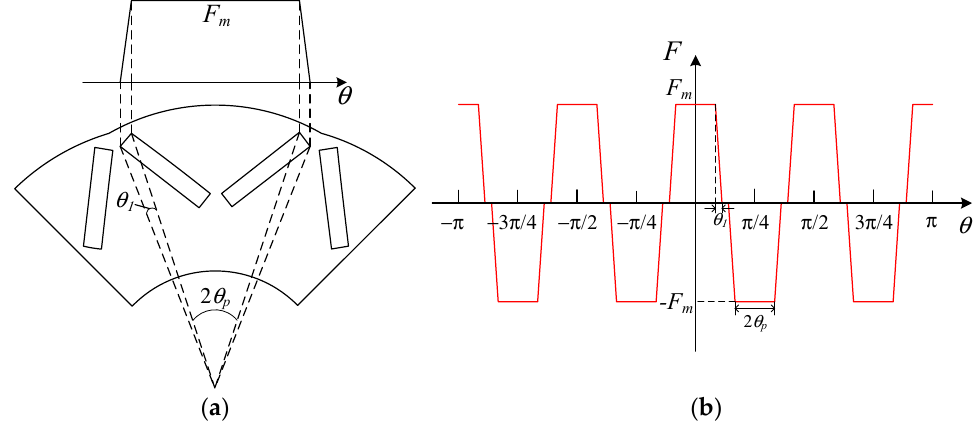
Figure 5. Permanent magnet magnetomotive force of AGE-IPMSM: ( a ) permanent magnetic field distribution and ( b ) permanent magnet MMF.